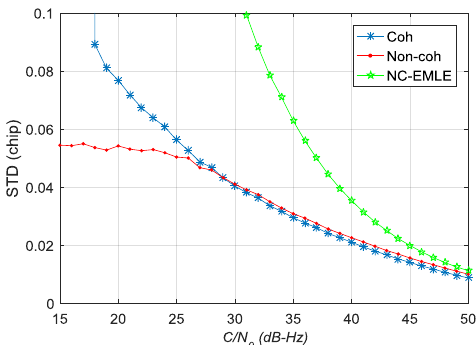
Figure 16. The STD values of estimation error of code phase error in different C / N 0 .